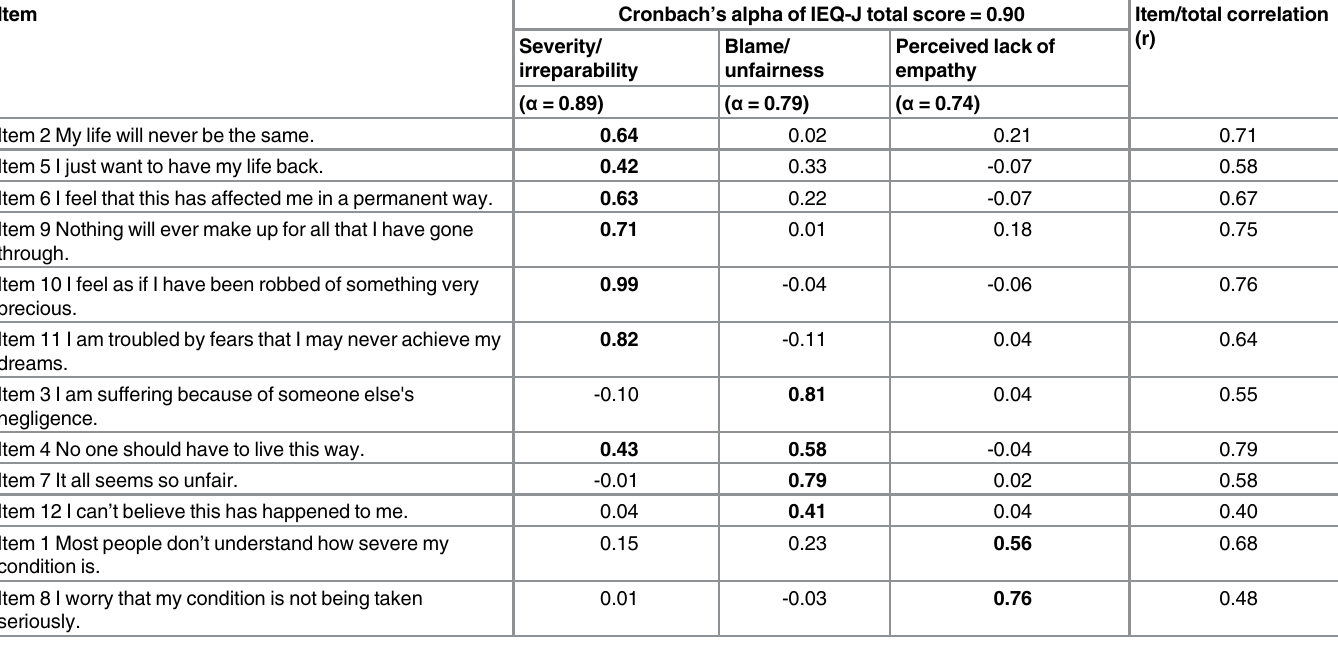
Table 2. Factor loadings and internal consistency of the IEQ-J for the three factors.